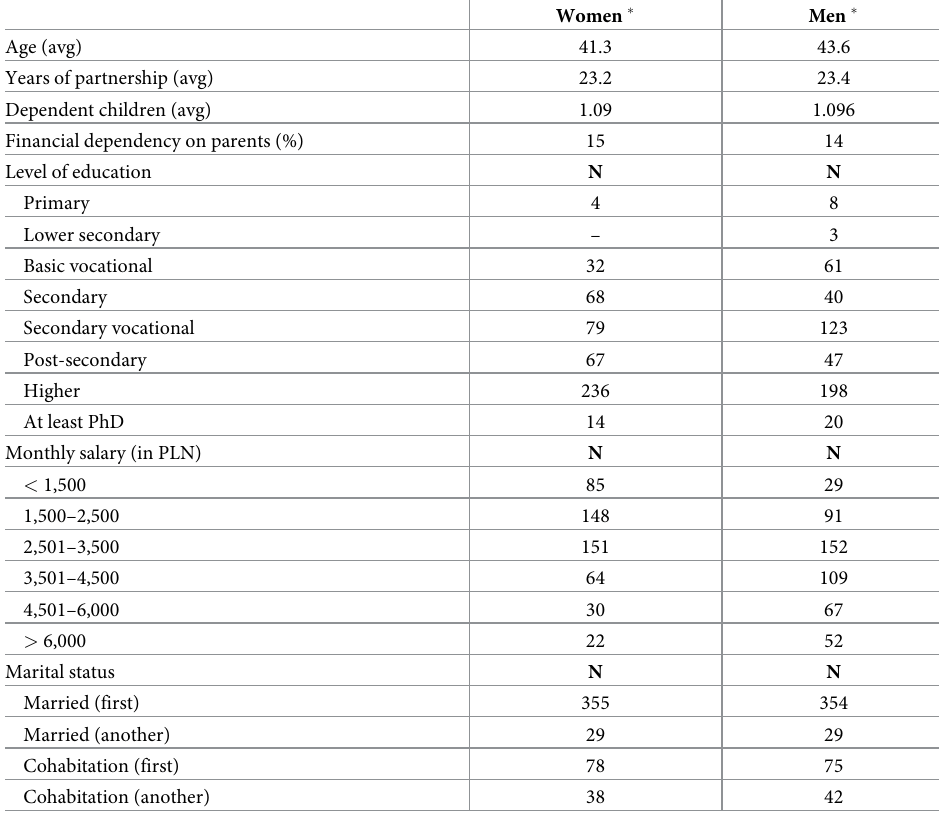
Table 1. Descriptive statistics of the